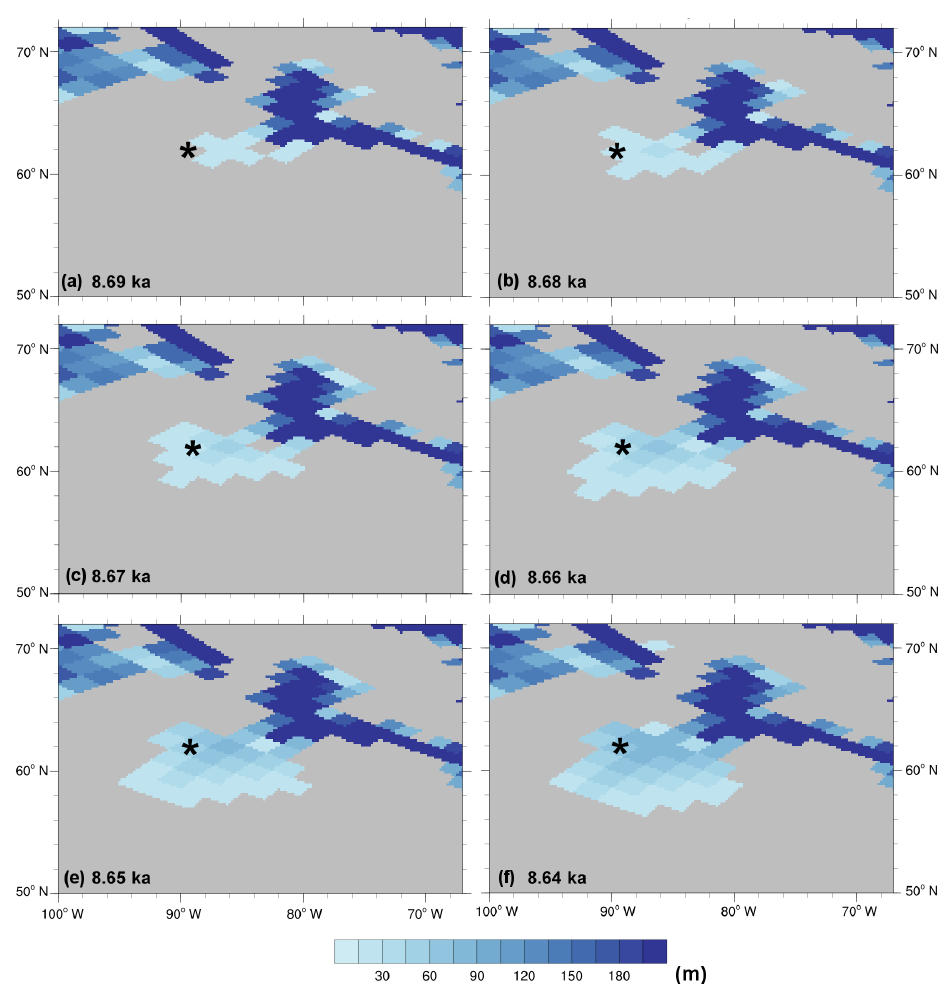
Figure 4. Bathymetry fields around Hudson Bay for different time slices (10-year time step) showing a gradual opening and deepening of the area. Black stars highlight a grid point as a